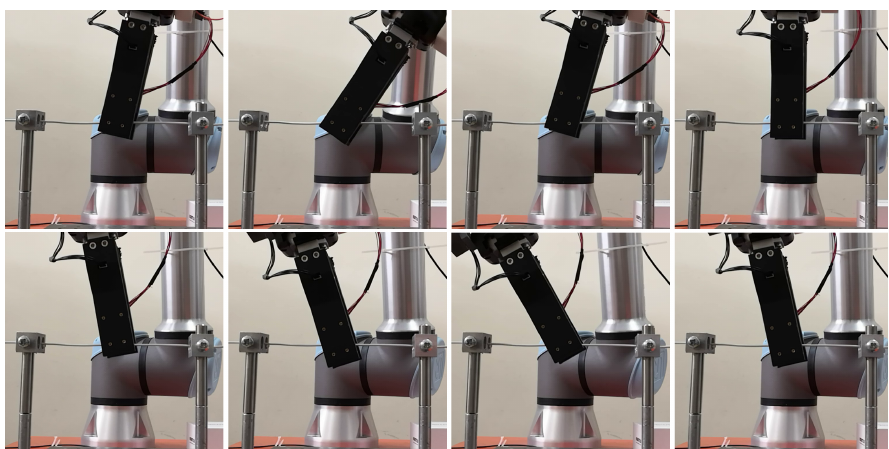
Figure 4. Different grasping poses for the acquisition of the training and testing data.